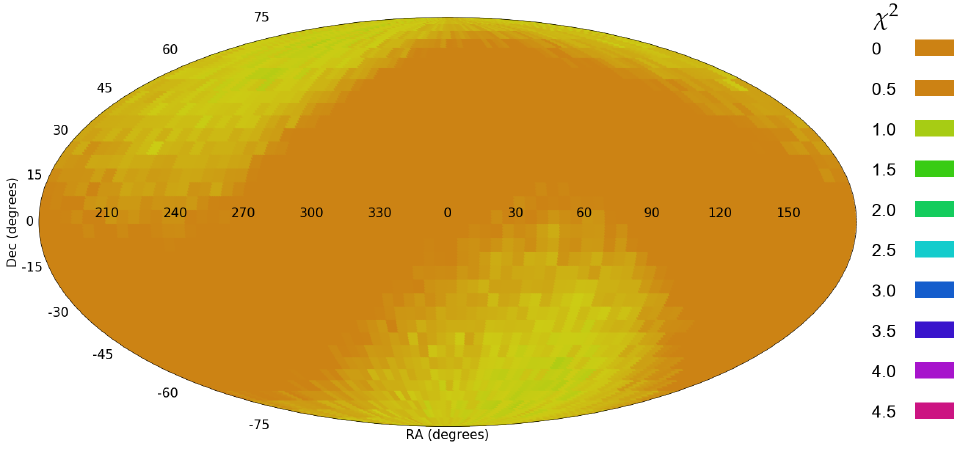
Figure 8. The χ 2 probability of the dipole axis when the galaxies are assigned with random spin di-